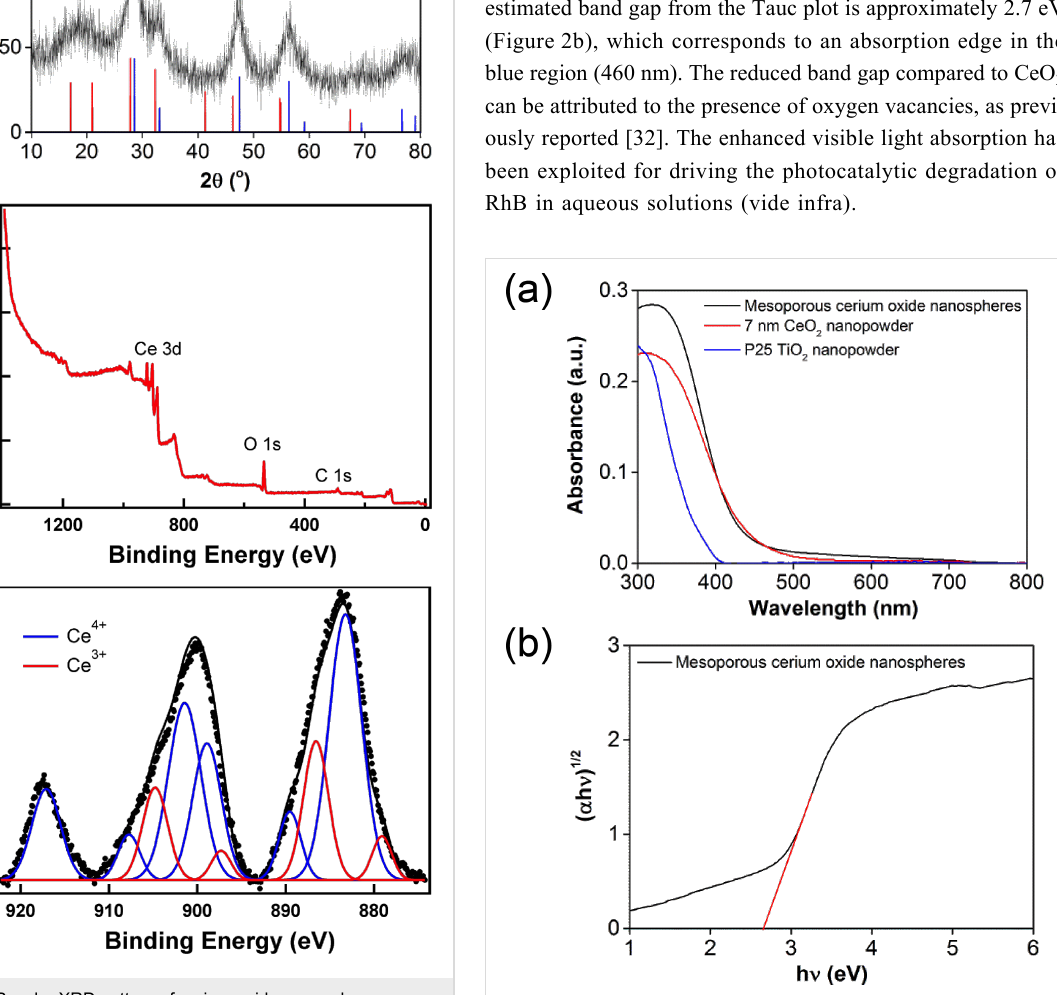
area under the fitted peaks, the concentration of Ce 3+ is only 23%, which deviates from the predicted stoichiometric value (57%). This observation suggests that the Ce 7 O 12 phase is mixed with some CeO 2 phase on the surface. The nominal molecular formula of the material based on the XPS data is CeO 1.89, comprising of around 54% Ce 7 O 12 and 46% CeO 2 . The mixture of two crystalline forms is also observed in our XRD measurements and TEM results (vide infra).